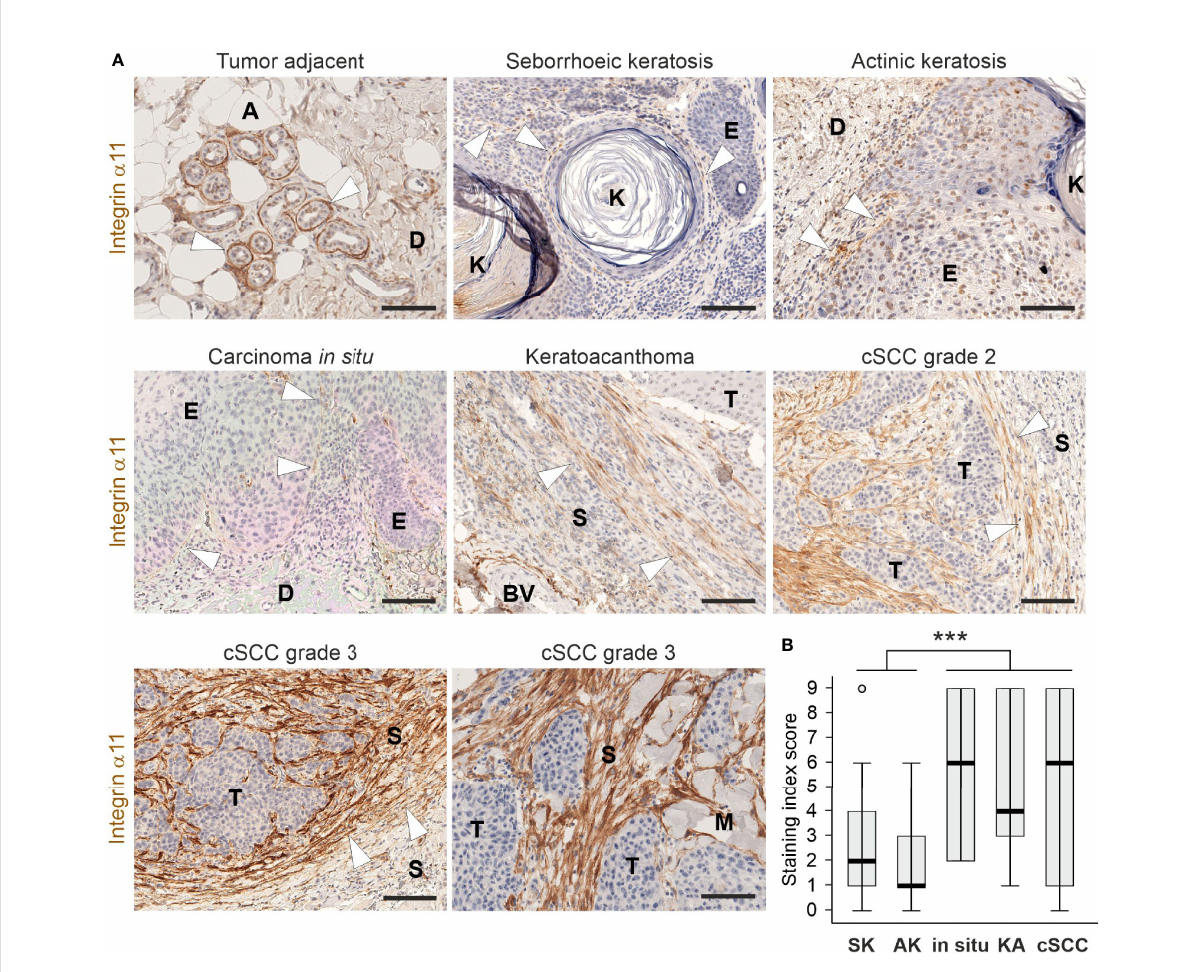
FIGURE 1 Expression and localization of integrin a 11 in human cutaneous lesions. (A) Representative images of integrin a 11 expression and localization in human skin lesions, stained with a monoclonal anti-human integrin a 11 antibody (clone 210F4B6A4) (26). Integrin a 11 showed strong expression around sweat glands in the tumor-adjacent normal skin, likely in the myoepithelial cells of the acini (arrowheads); scant positive signals in spindle-shaped cells at the dermal-epidermal junction (arrowheads) in benign seborrheic keratosis, premalignant actinic keratosis, and in squamous carcinoma in situ ; generally moderate or strong signals in spindle-shaped cells distributed within the fi brillar stroma; and present in a tangle-like pattern at the tumor − stroma interphase (arrowheads) in malignant keratoacanthoma and cutaneous squamous cells carcinomas (cSCC). Stromal a 11 staining is strong in grade 3 cSCCs. (B) A boxplot diagram representing the staining index score in seborrhoeic keratosis (SK), actinic keratosis (AK), in situ carcinomas (in situ), keratoacanthomas (KA), and cSCCs. Arrowheads, a 11 signals. A, adipocyte, BV, blood vessel; D, dermis; E, epidermis; K, keratin; M, muscle; S, stroma; T, tumor. Scale bars, 100 m m. ***,